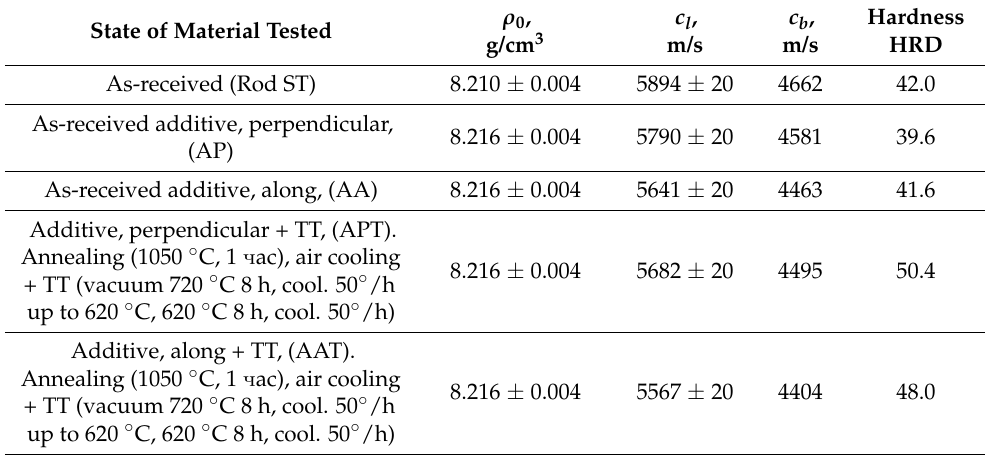
Table 2. The state of the material and the measured values of density ρ 0 , the longitudinal speed of sound c l and the hardness of the Inconel 718 alloy in various states, and the calculated bulk speed of sound c b